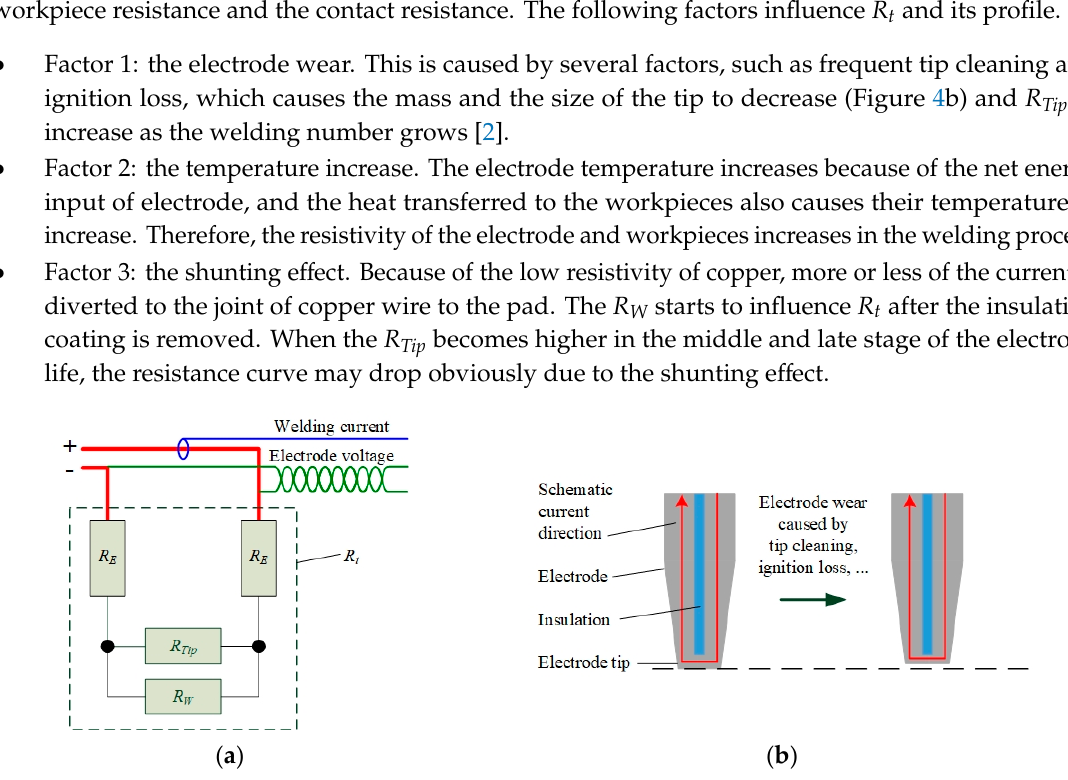
Figure 4. Schematic diagram for dynamic resistance analysis: ( a ) equivalent circuit; ( b ) electrode wear.